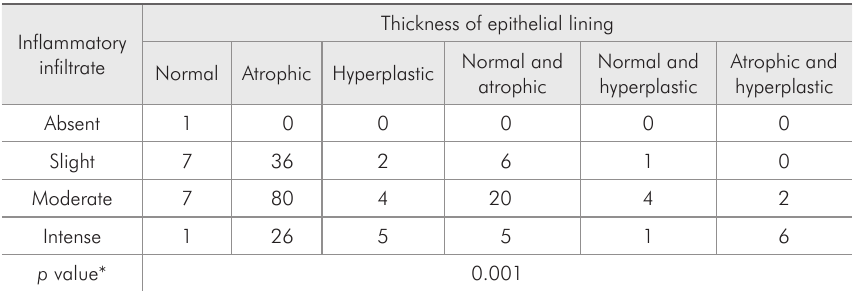
Figure 1 - Periapical cyst. Cystic wall covered by atrophic stratified squamous epithelial lining exhibiting moderate mononuclear inflammatory infiltrate (H&E; original magni- fication, 400 × ).